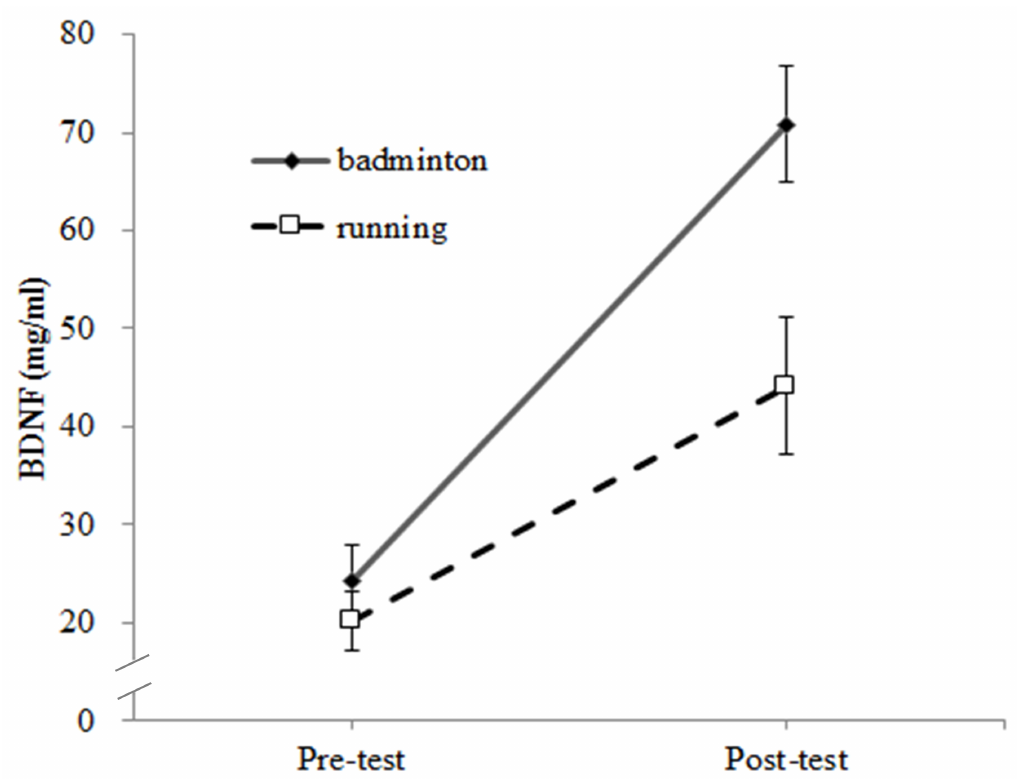
Figure 1. Effects of different acute exercise sessions on serum BDNF in pre and post exercise.